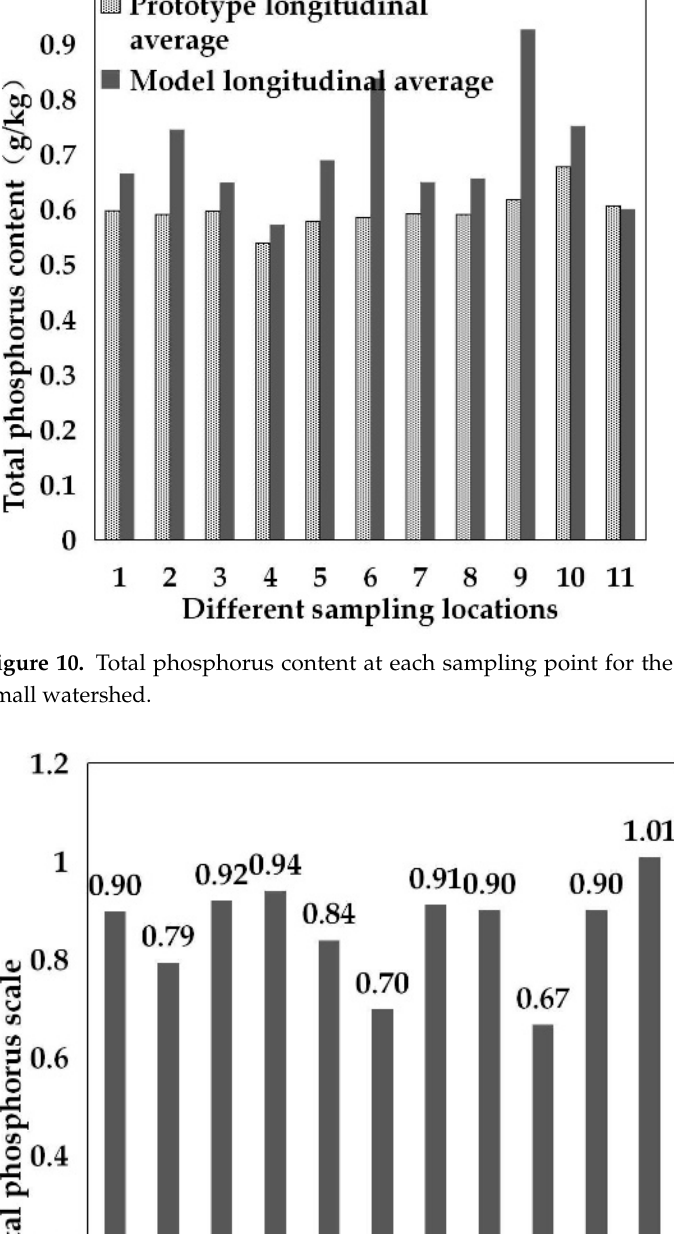
Figure 9. Fixed scale of pollutant nitrogen rate at different sampling points.